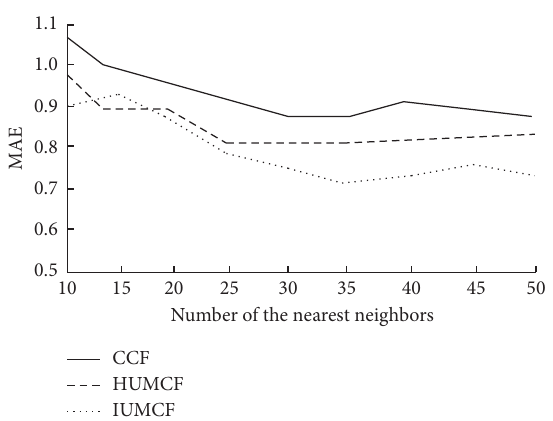
Figure 5: Comparison of MAE results of the same user with different numbers of neighbors.